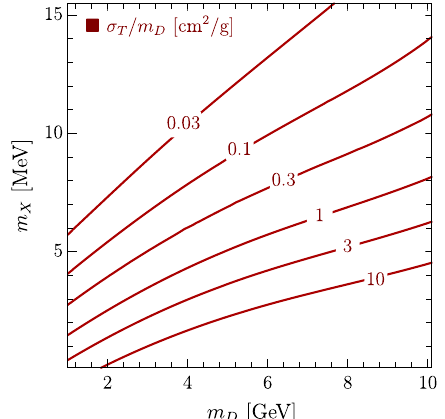
Fig. 12 Contours of self-interaction cross-section σ T / m D at dwarf galaxies scale ( v = 10 km/s) in the ( m D , m X ) plane. For each point the value of g X was fitted using relic density constraint